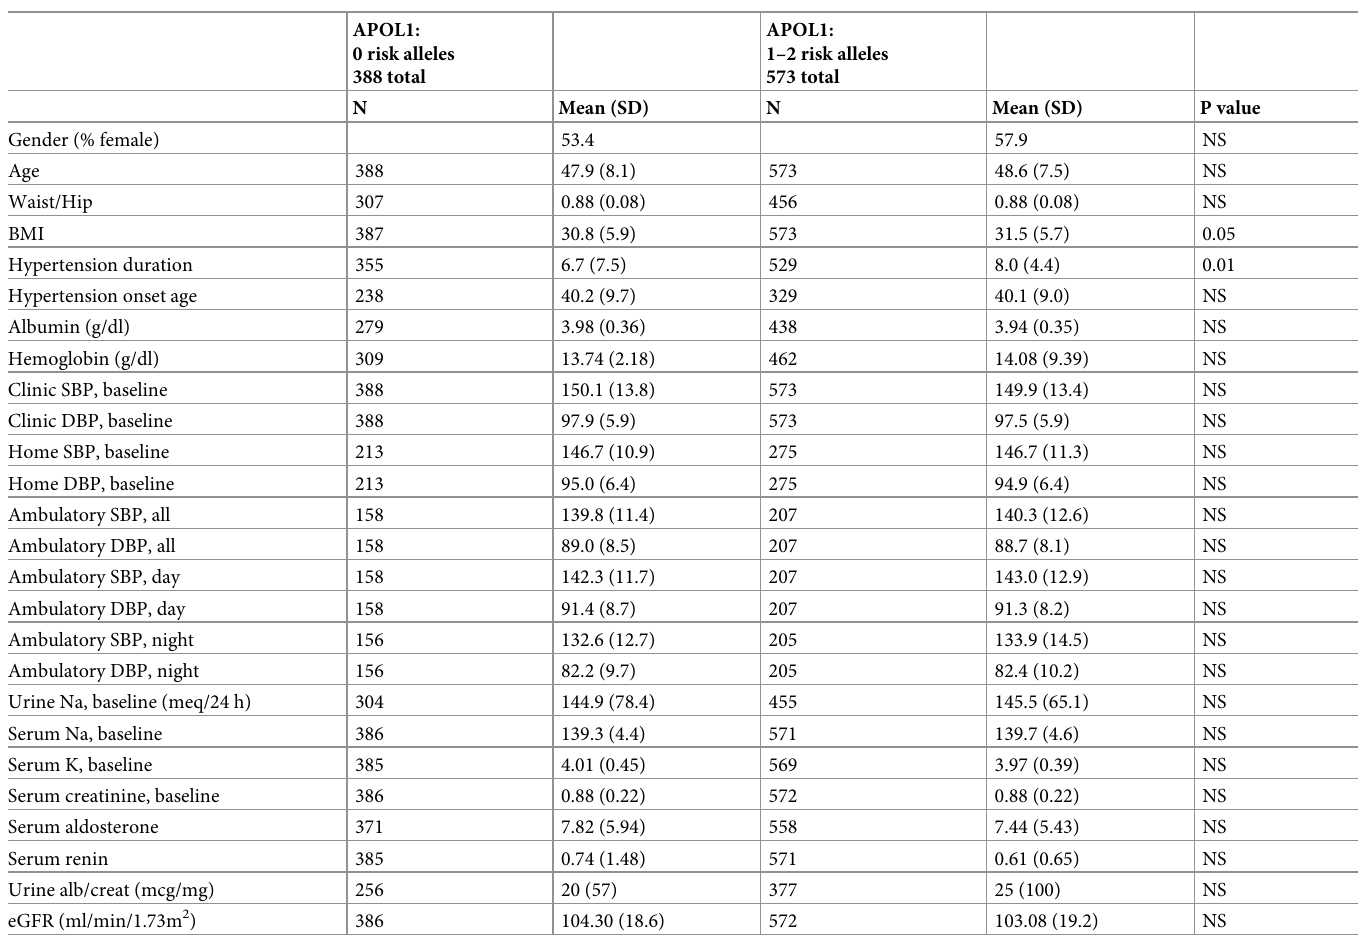
Table 3. Baseline characteristics.